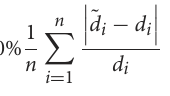
the manual error. The error between the estimated and